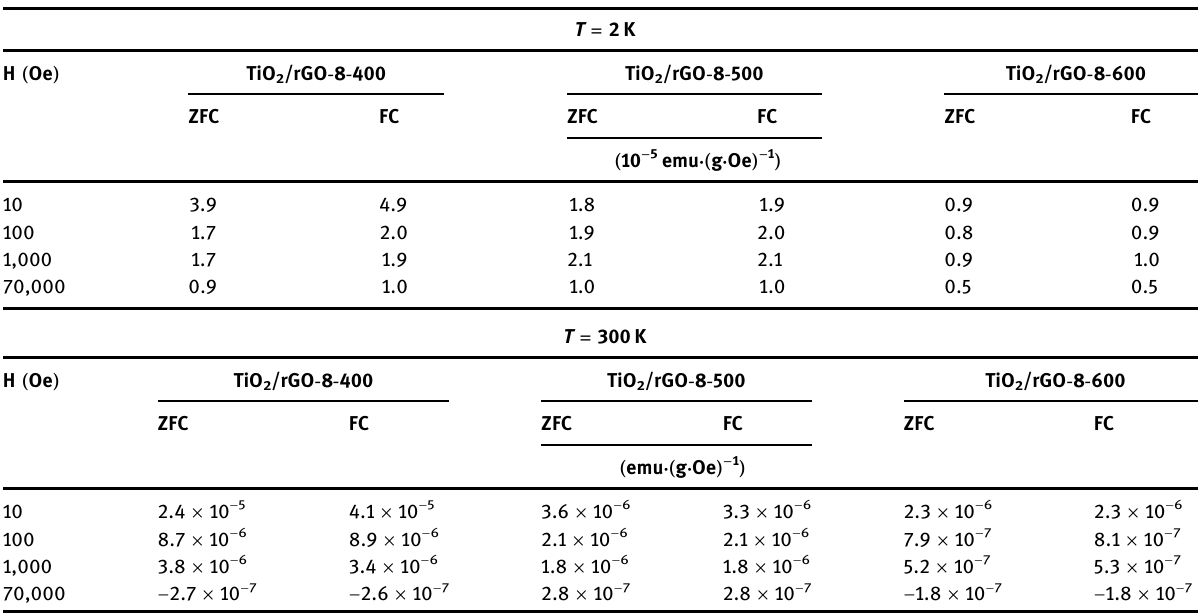
Table 2: Magnetic susceptibility at temperatures of 2 and 300